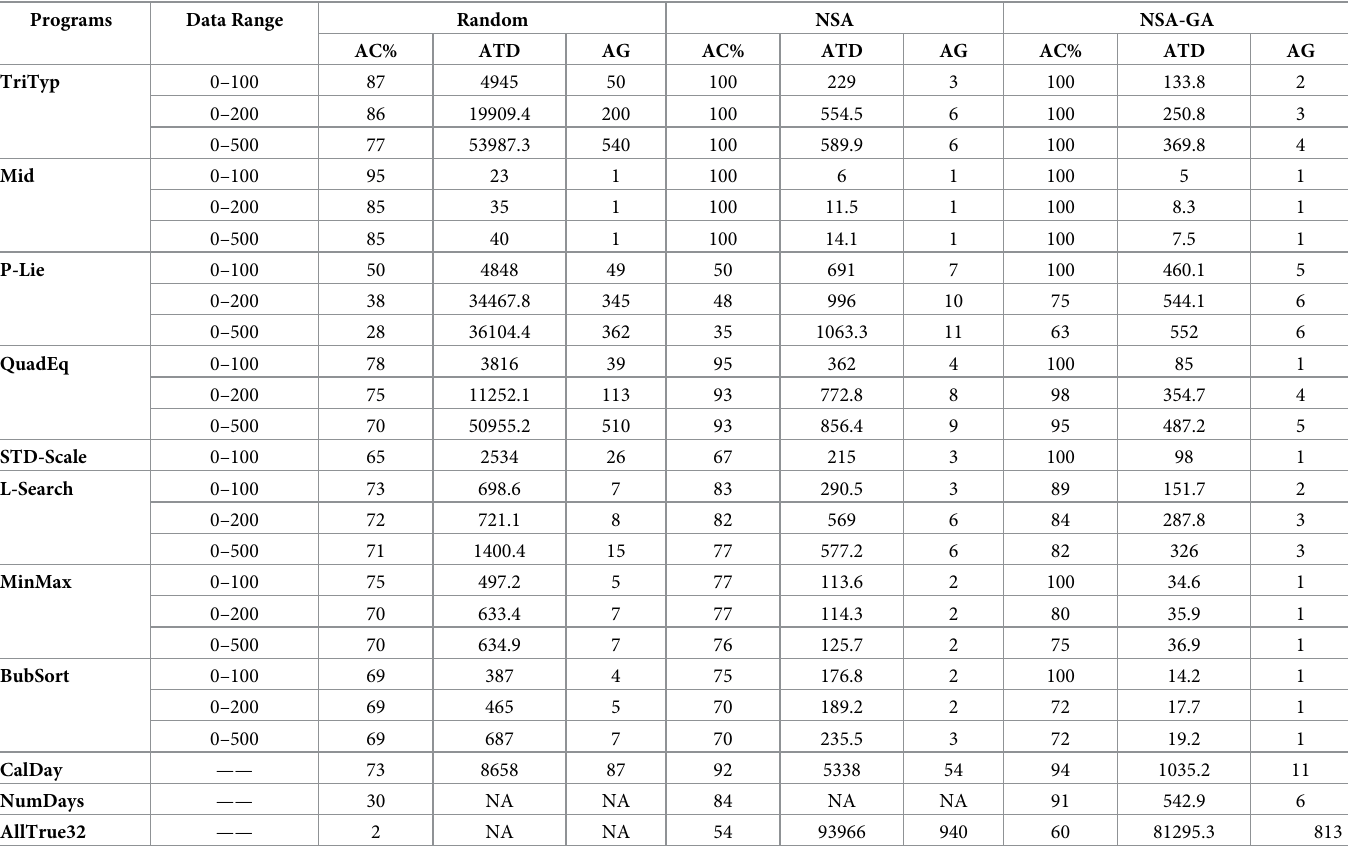
Table 2. Comparison of results between NSA-GA, NSA, and random testing on all programs using integer data type and different range. Programs Data